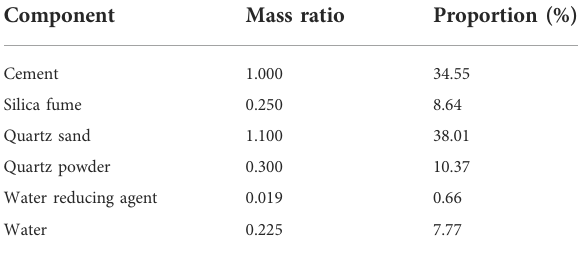
TABLE 3 Proportion of UHPC.